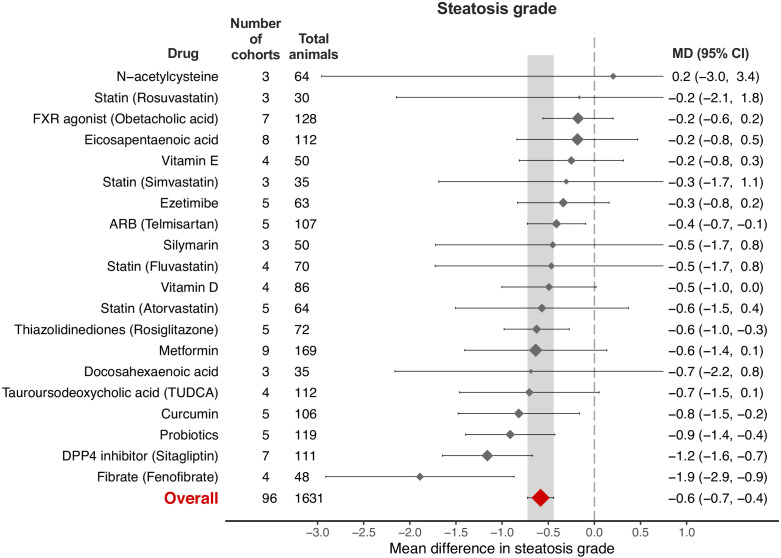
Meta-analysis of steatosis grade in rodent studies of NAFLD by individual drug.Forest plot with subgrouping by individual drug. Individual studies have been hidden and only subgroup summaries are illustrated. Total animals is the sum of control and interventional animals for each subgroup. ARB, angiotensin receptor blocker; CI, confidence interval; DPP4, Dipeptidyl peptidase-4; FXR, Farnesoid X receptor; MD, mean difference; TUDCA, tauroursodeoxycholic acid.